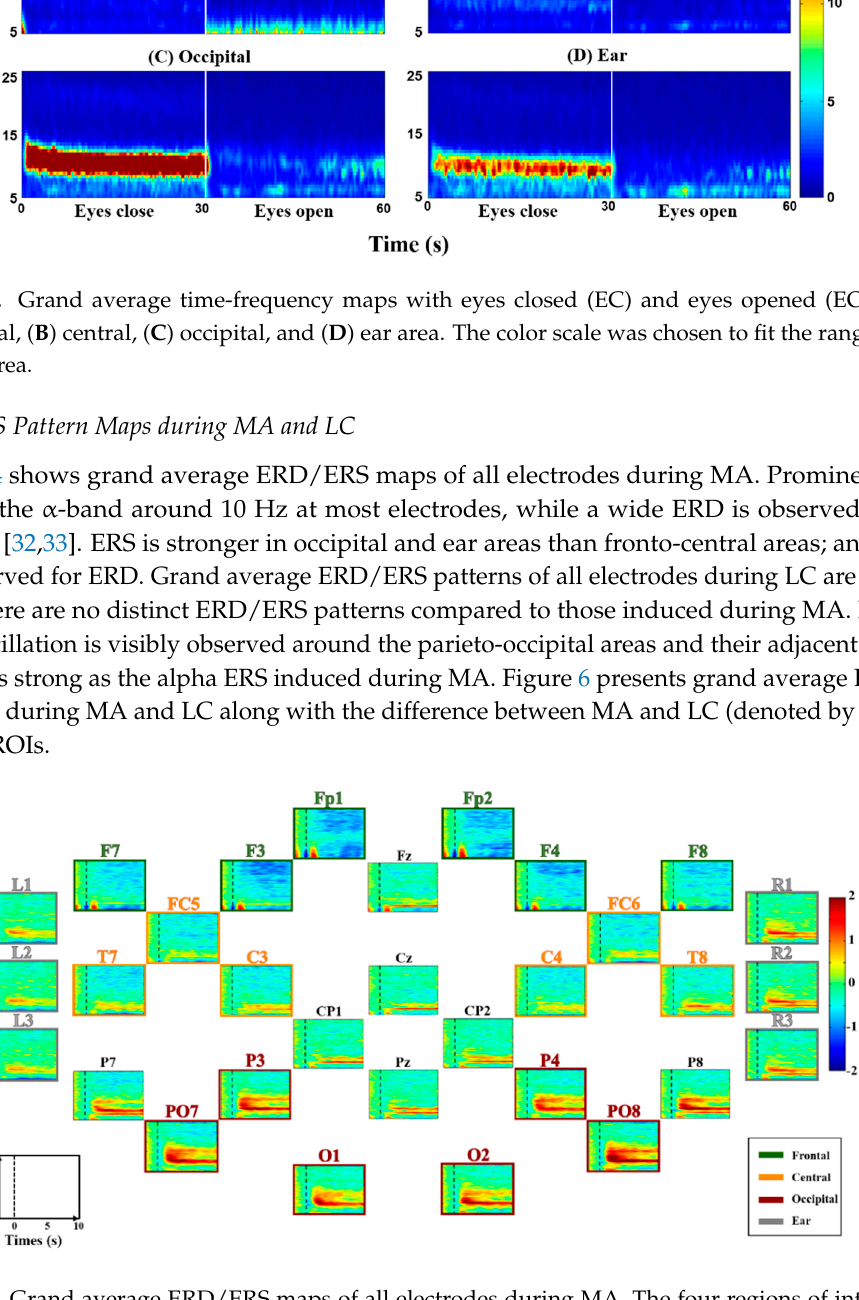
Figure 4. Grand average ERD/ERS maps of all electrodes during MA. The four regions of interest (ROIs), frontal, central, occipital, and ear area, are denoted by four different colored lines and titles for each map (green, orange, red, and gray), respectively. The x- and y-axis of each map indicate the task time from − 2–10 s based on task onset (t = 0 s), and the frequency band ranging from 1 to 50 Hz, respectively. ERD and ERS are presented in blue and red, respectively. Note that scalp- and ear-EEG are independently re-referenced using a CAR and a modified CAR, respectively.